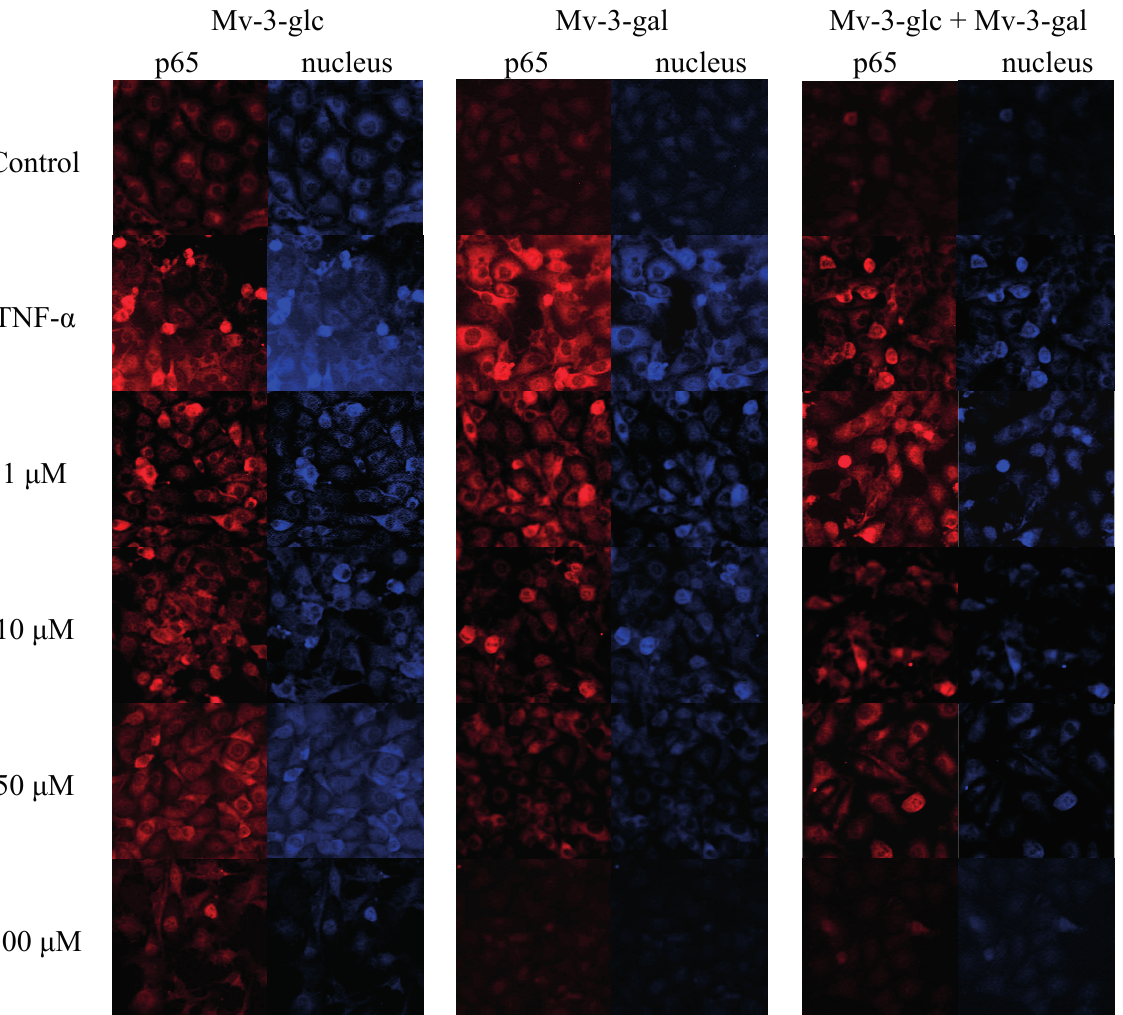
Figure 5. Effects of Mv-3-glc, Mv-3-gal, and their mixture (Mv-3-glc + Mv-3-ga) on NF- κ B pathway (endothelial p65 translocation) in